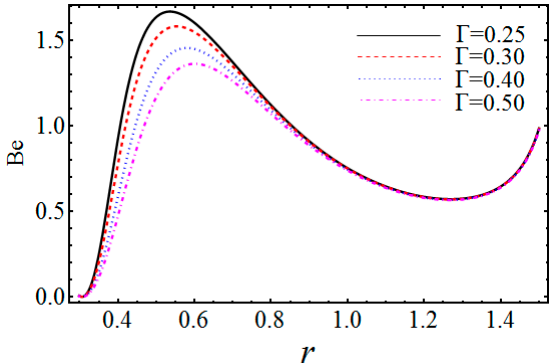
Figure 21. Curves of Be with fixed Γ where θ = 0.1, ϕ = 0.5, δ = 0.1, ε = 0.2, V = 0.3, λ 1 = 0.1, z = Figure 21. Curves of 𝐵𝑒 with fixed Γ where 𝜃 = 0.1, 𝜑 = 0.5, 𝛿 = 0.1,𝜀 = 0.2,𝑉 = 0.3, 𝜆 (cid:2869) = 0.1, 𝑧 = Figure 21. Curves of 𝐵𝑒 with fixed Γ where 𝜃 = 0.1, 𝜑 = 0.5, 𝛿 = 0.1,𝜀 = 0.2,𝑉 = 0.3, 𝜆 (cid:2869) = 0.1, 𝑧 = 0, t = 0.1, Gc = 0.01, Λ = 1, Nt = 0.5, Br = 1, Gr = 5, Ω = 0.3, Nb = 0.9, Q = 1.. 0, 𝑡 = 0.1, 𝐺𝑐 = 0.01,Λ = 1, 𝑁𝑡 = 0.5, 𝐵𝑟 = 1, 𝐺𝑟 = 5, Ω = 0.3,𝑁𝑏 = 0.9, 𝑄 = 1. 0, 𝑡 = 0.1, 𝐺𝑐 = 0.01,Λ = 1, 𝑁𝑡 = 0.5, 𝐵𝑟 = 1, 𝐺𝑟 = 5, Ω = 0.3,𝑁𝑏 = 0.9, 𝑄 = 1.